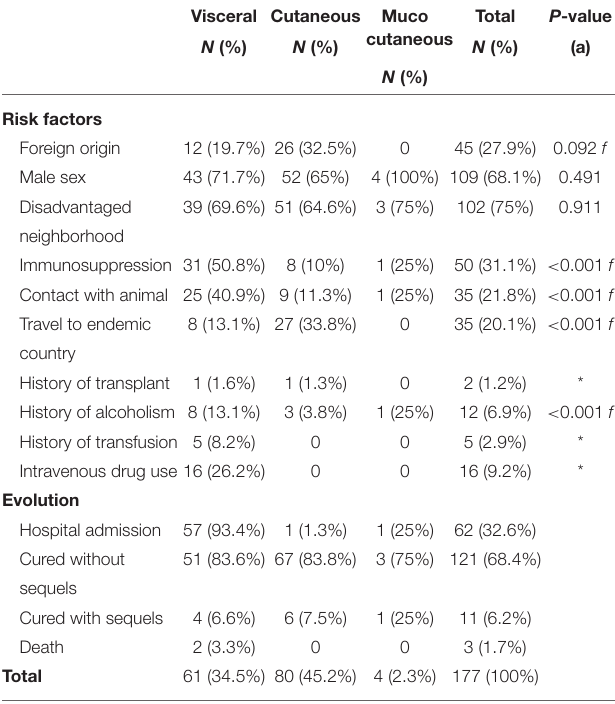
TABLE 4 | Type of Leishmaniasis according to risk factors and evolution. Visceral Cutaneous Muco Total P cutaneous